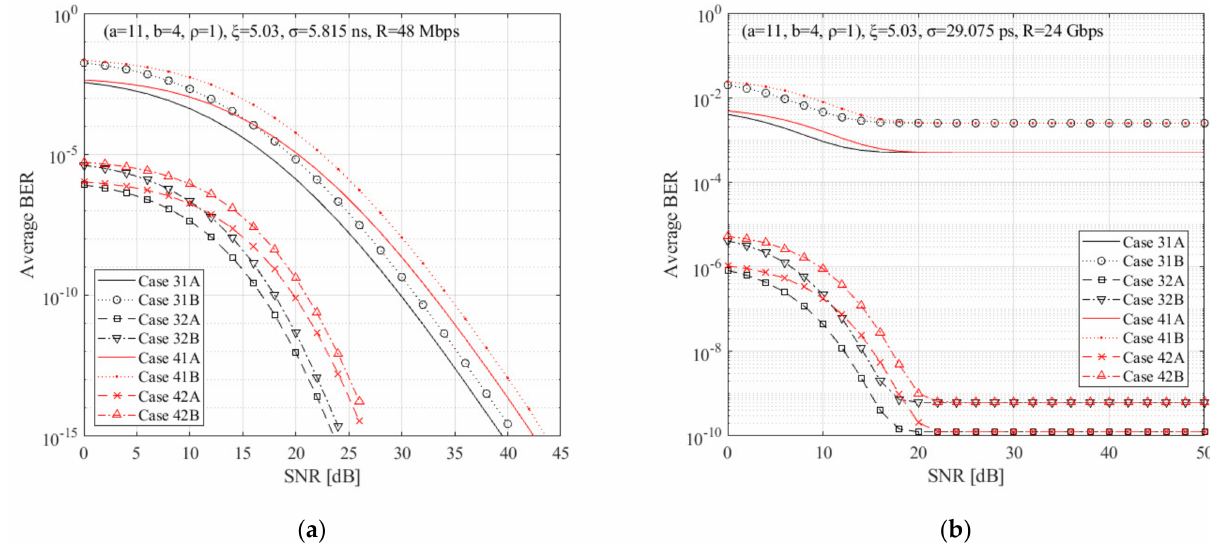
Figure 5. ABER versus expected SNR for ( a = 11, b = 4, ρ = 1), ξ = 5.03, OOK-RZ/NRZ schemes, and various diversity and DF multi-hop parameters, with ( a ) R = 48 Mbps, σ = 5.815 × 10 − 9 s ( α = 10 − 8 s, β = 4) and ( b ) R = 24 Gbps, σ = 29.075 × 10 − 12 s ( α = 5 × 10 − 11 s, β = 4). The studied curve cases are codified as follows: Case 31A: OOK-RZ, N = 3 , M = 1; Case 31B: OOK-RZ , N = 3 , M = 5; Case 32A: OOK-RZ , N = 9 , M = 1; Case 32B: OOK-RZ , N = 9 , M = 5; Case 41A: OOK-NRZ , N = 3 , M = 1; Case 41B: OOK-NRZ , N = 3 , M = 5; Case 42A: OOK-NRZ , N = 9 , M = 1; Case 42B: OOK-NRZ , N = 9 , M = 5.